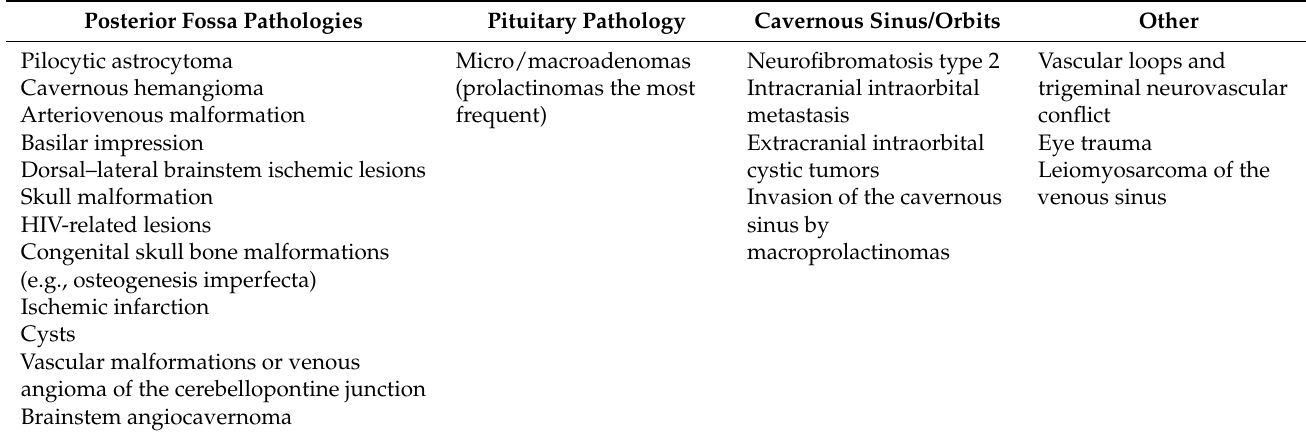
Table 2. Lesions associated with SUNCT-like